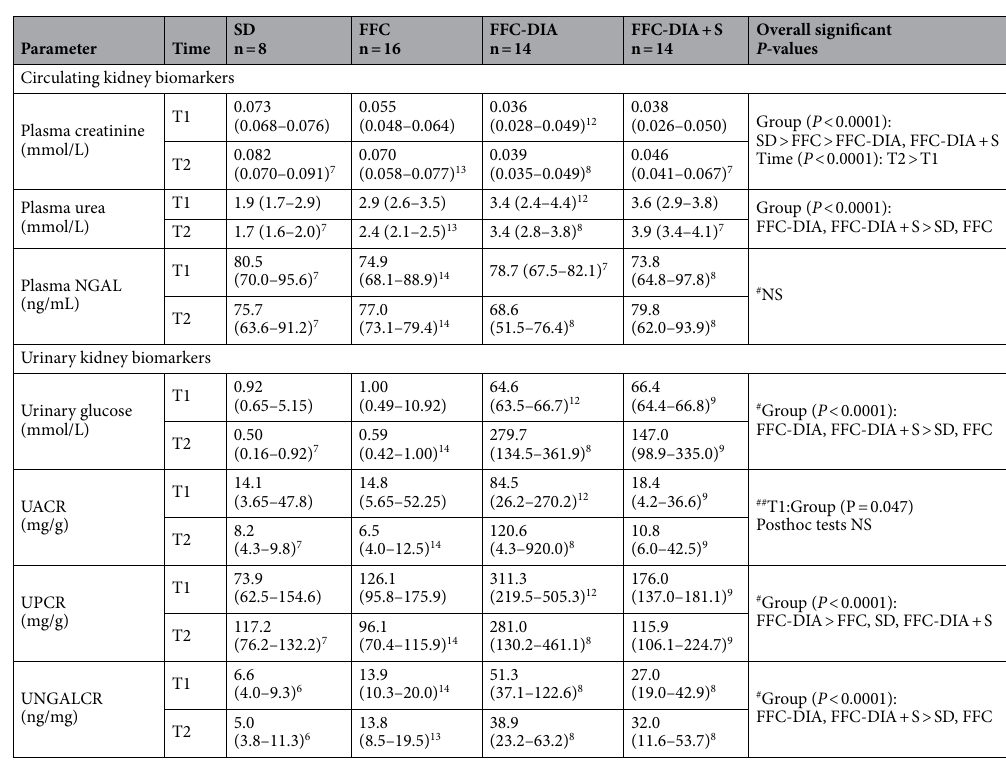
Table 2. Kidney urine and circulating biomarkers in castrated male Göttingen Minipigs fed with standard diet (SD) or fat, fructose and cholesterol rich diet (FFC) with or without additional salt (S) and with or without streptozotocin-induced diabetes (DIA). NGAL:neutrophil gelatinase-associated lipocalin, UACR: urinary albumin to creatinine ratio, UPCR: urinary protein to creatinine ratio, UNGALCR: urinary NGAL to creatinine ratio. Two parameters were influenced by cohort: Plasma creatinine (CoB > CoC) (P = 0.034) and plasma urea (CoA > CoC (P = 0.0003). T1: Approx. 7 months of diet-feeding, T2: Approx. 13 months of diet feeding. Median and interquartile range (Q1-Q3). Superscript: Actual numbers included in the statistical analysis due to missing data. P-values from post hoc tests were adjusted using Bonferroni correction. # Logaritmic transformation, ## Non parametric